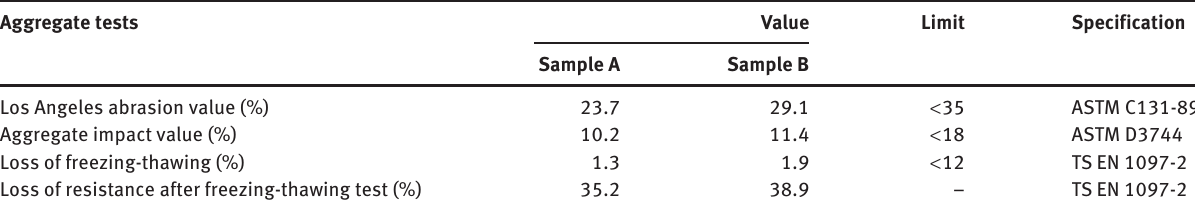
Table 5 Test results of the aggregate